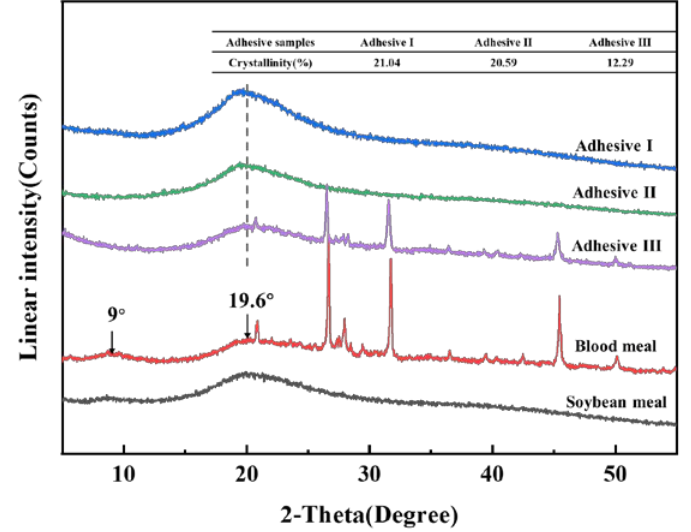
Figure 2. X-ray diffraction (XRD) patterns of soybean meal, blood meal and investigated adhesives.